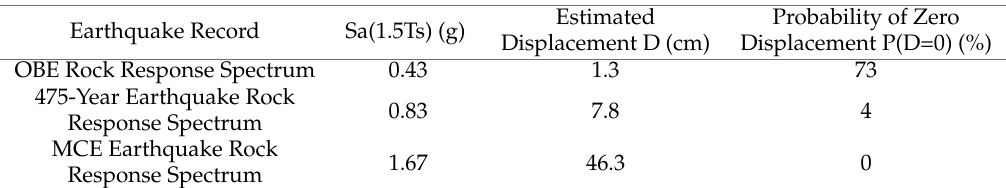
Table 5. Deviatoric Slope Displacements of Upstream Slope.